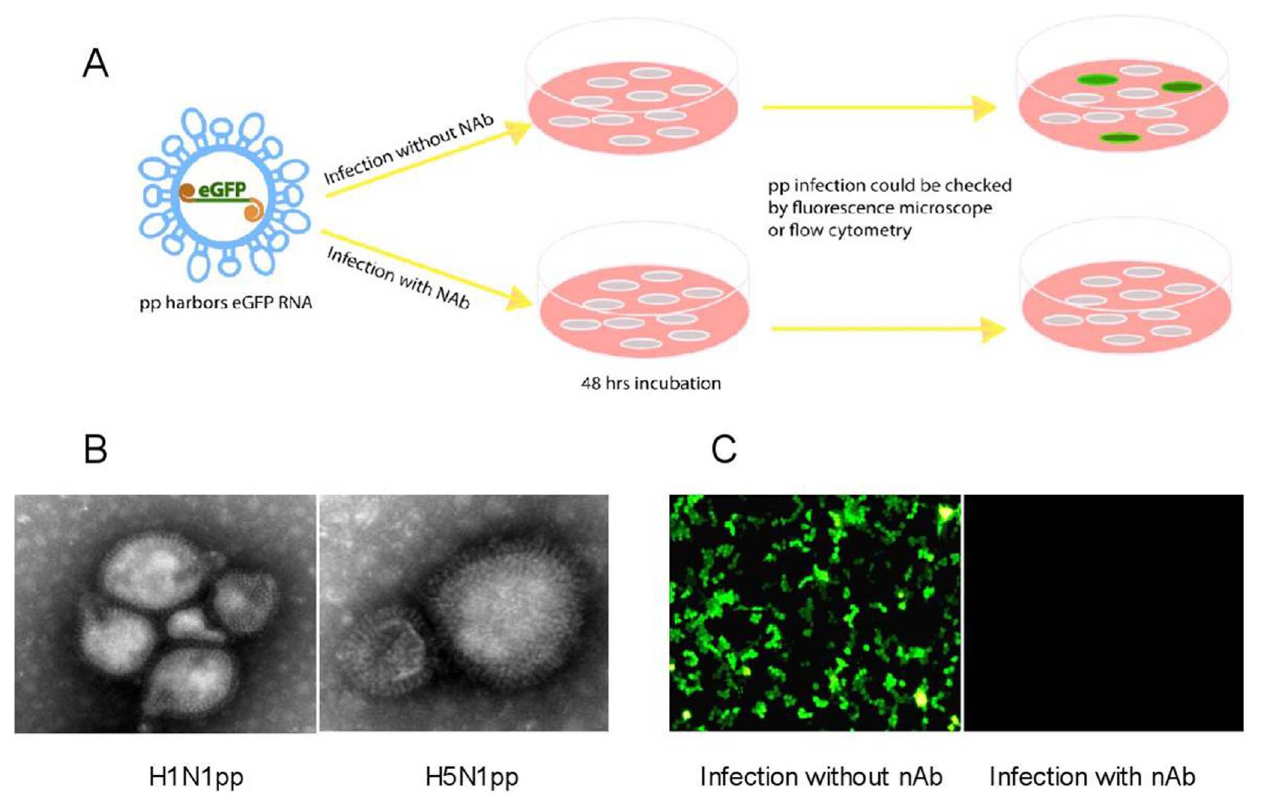
Figure 1. Use of pp in nAb detection and electron microscopic observation. A. The pp were composed primarily of three viral elements: gag-pol, the viral mimic genome, and a reporter gene ( e.g ., eGFP) were incorporated into the artificial viral genome. B. Transmission electron microscopic image showing H5N1pp and H1N1pp. C. The pp-infected cells expressed GFP and could be visualized by fluorescence microscopy; nAbs were quantified based on the GFP: cell ratio.